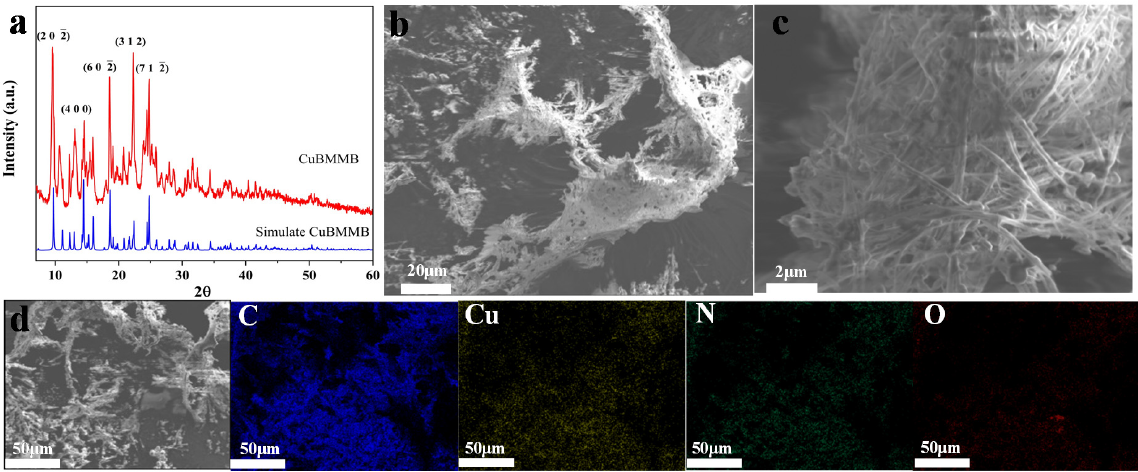
Figure 2. Structure, morphology, and composition analyses: ( a ) XRD pattern; ( b , c ) SEM image of CuBMMB; ( d ) SEM elemental mapping of C, Cu, N, and O in CuBMMB. CuBMMB; ( d ) SEM elemental mapping of C, Cu, N, and O in